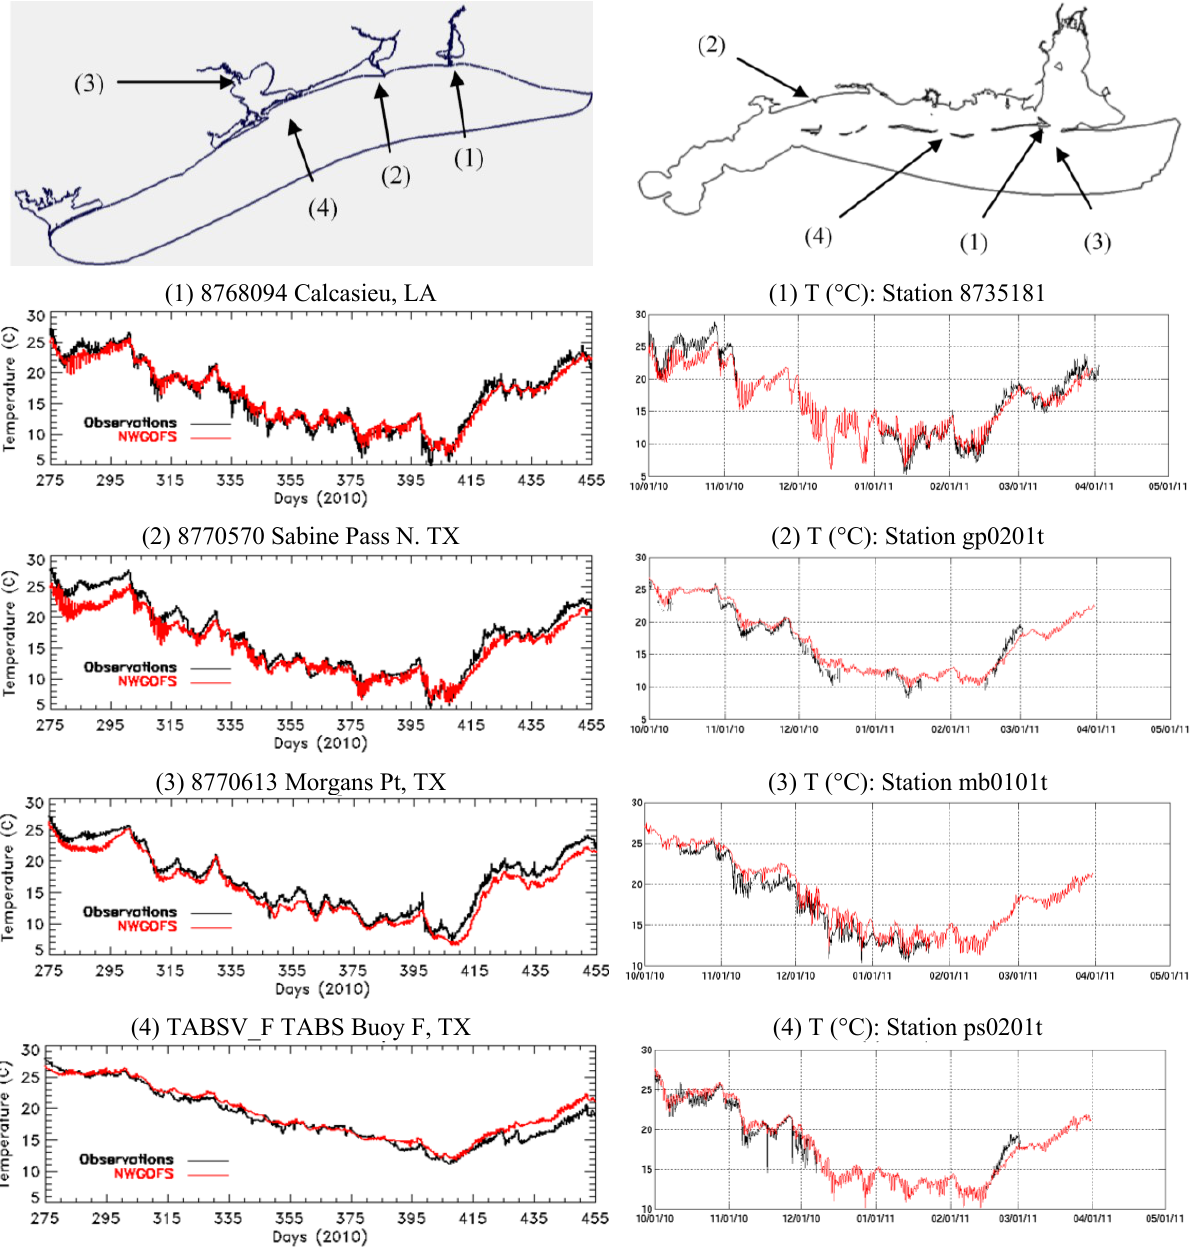
Figure 8. Simulated (red) and observed (black) temperature time series at stations in NWGOFS (left column) and NEGOFS (right column) from 1 November 2010 to 31 December 2010.